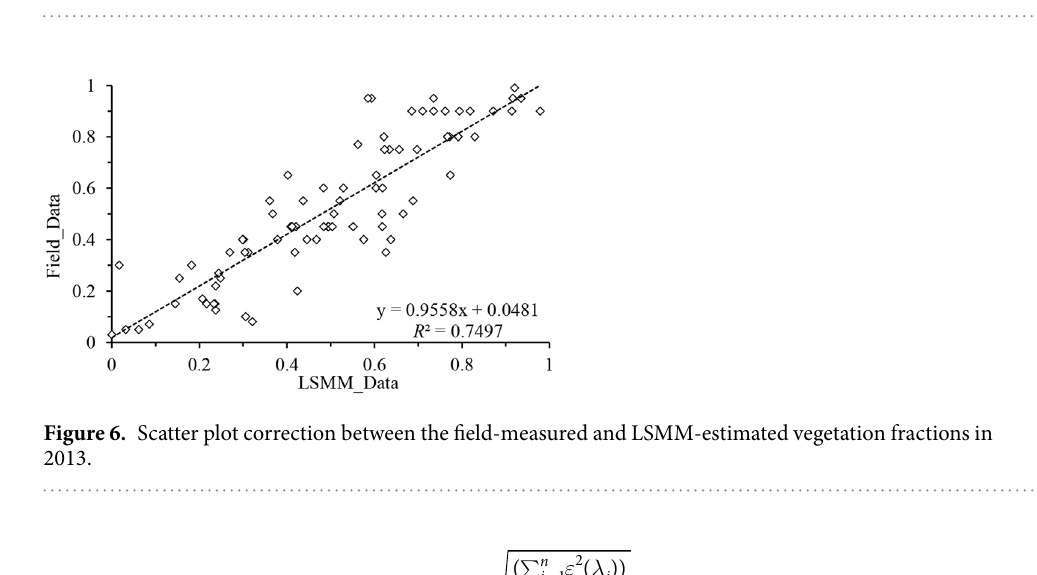
Figure 5. Averaged reflectances of endmembers.